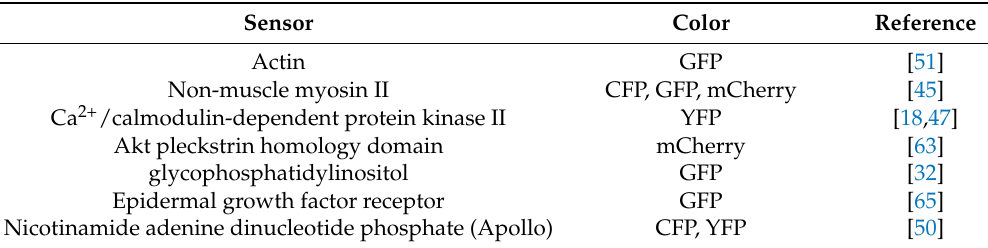
Table 2. Single-fluorescent protein homotransfer